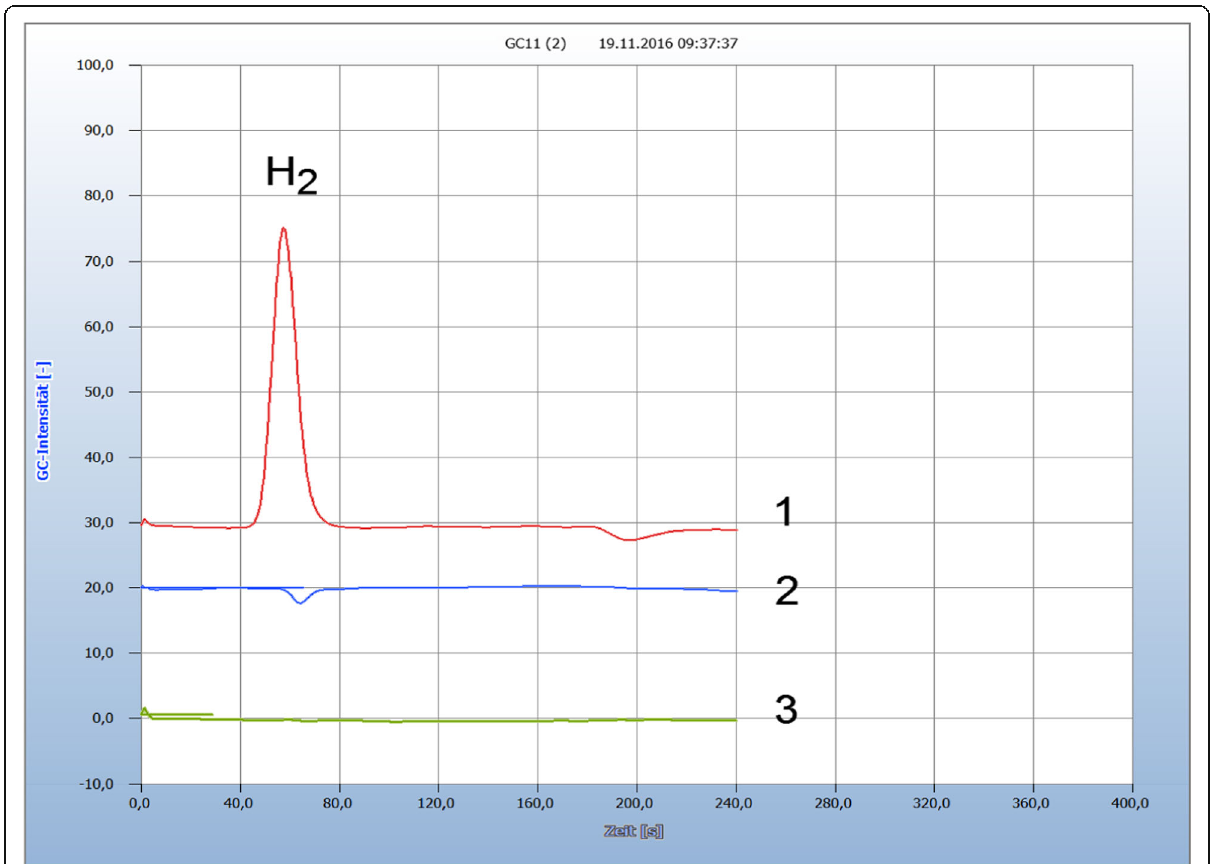
Fig. 4 Efficacy of oil of cloves. 1, fish; 2, added streptomycin; 3, added oil of cloves. GC-column 1: silica